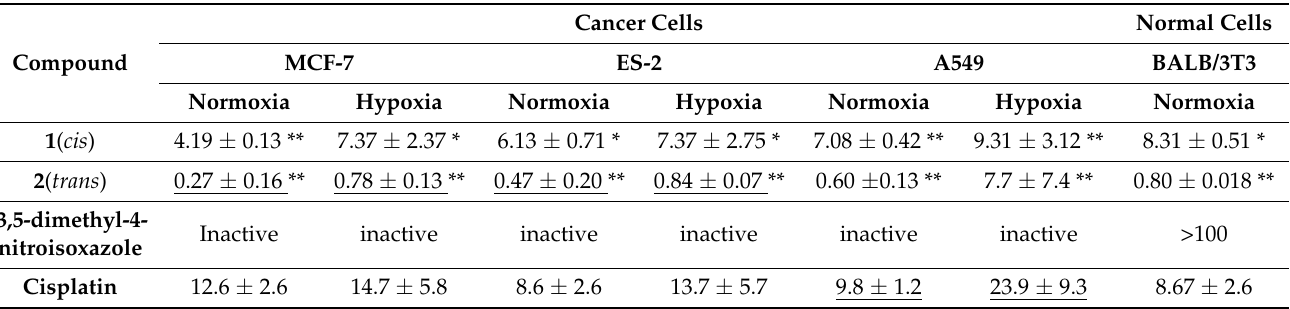
Table 2. Cytotoxic activity of platinum derivatives 1–2 , 3,5-dimethyl-4-nitroisoxazole ligand and reference cisplatin in normoxia and hypoxia conditions against some cancer and normal cell lines determined in the SRB (sulforhodamine B) viability assay. Data are given as inhibitory